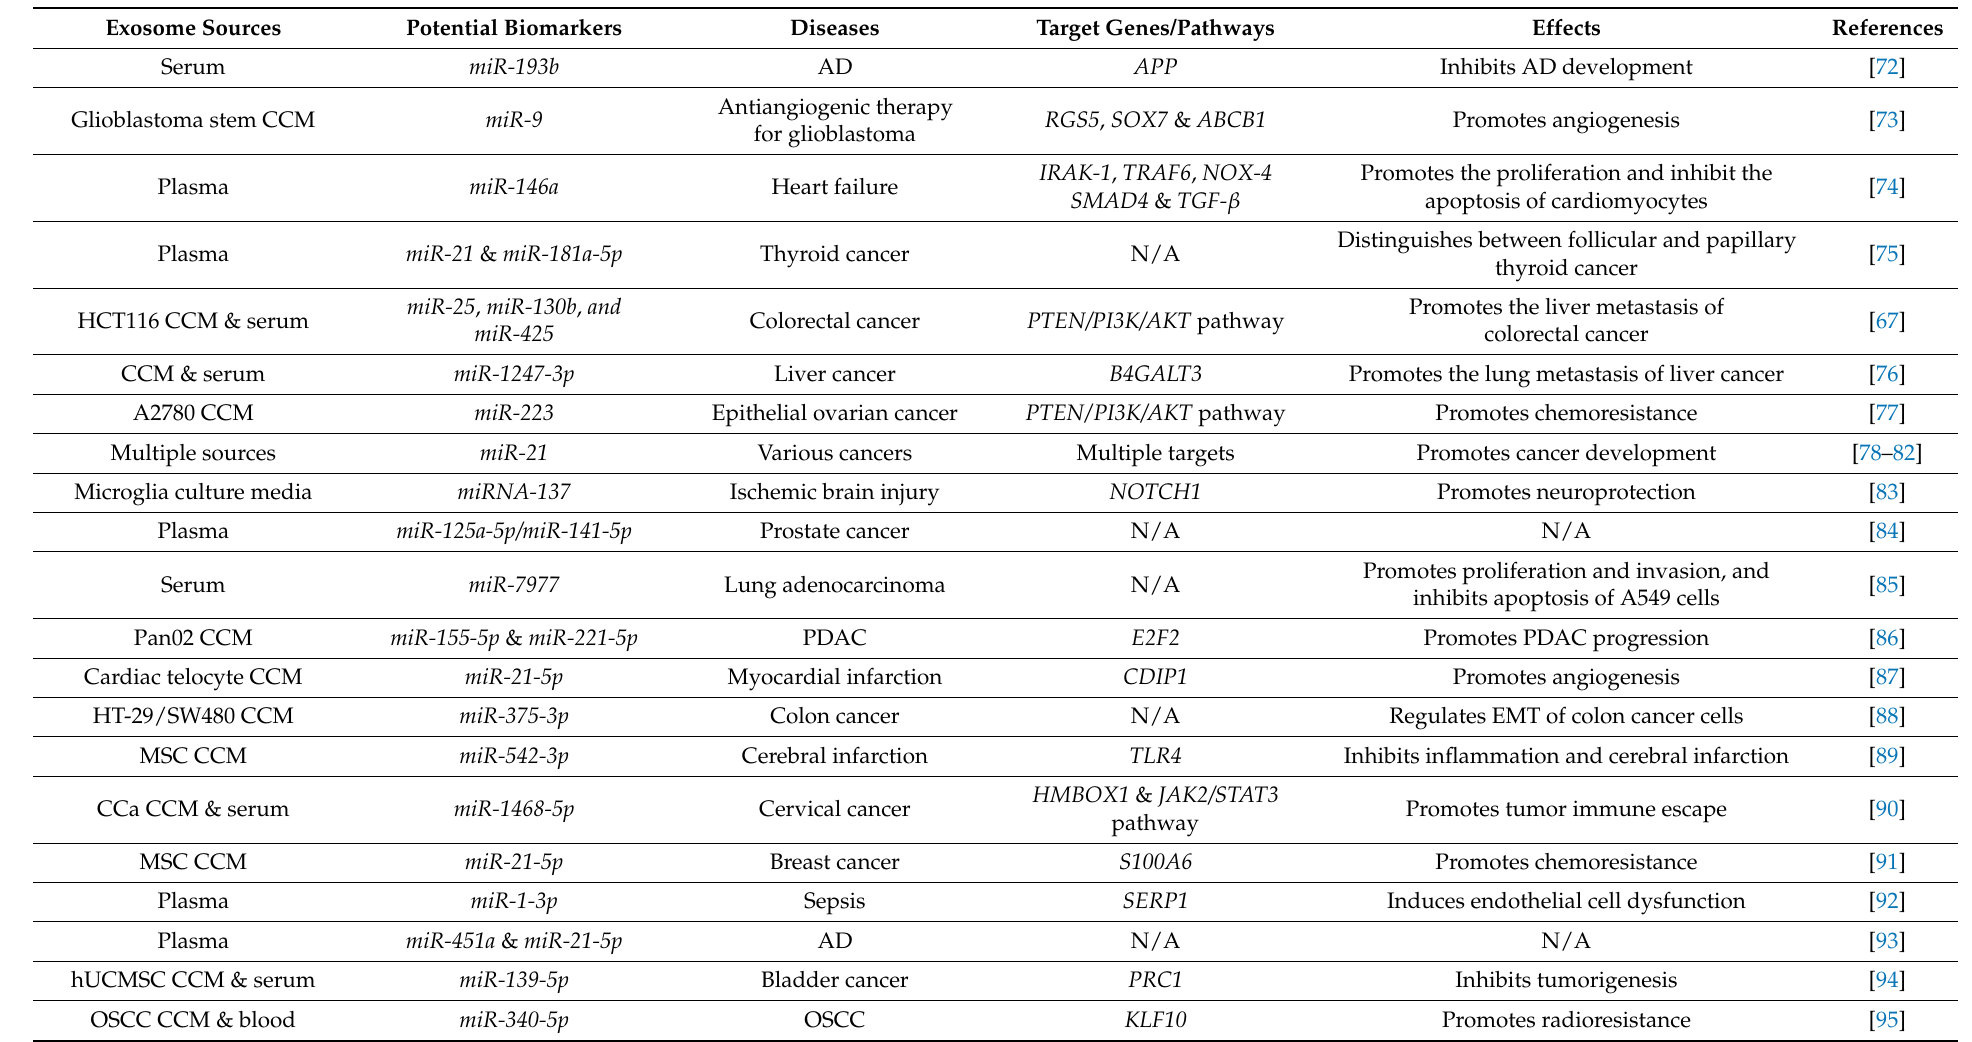
Table 2. Summary of exosomal miRNAs as potential disease